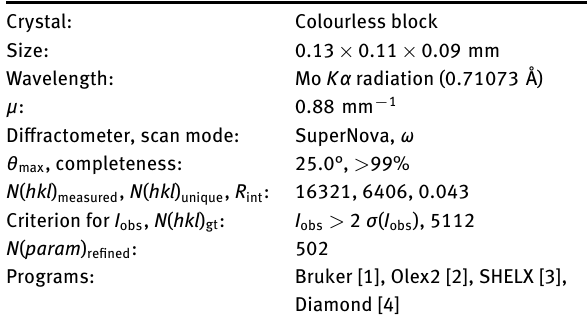
Table 1: Data collection and handling.